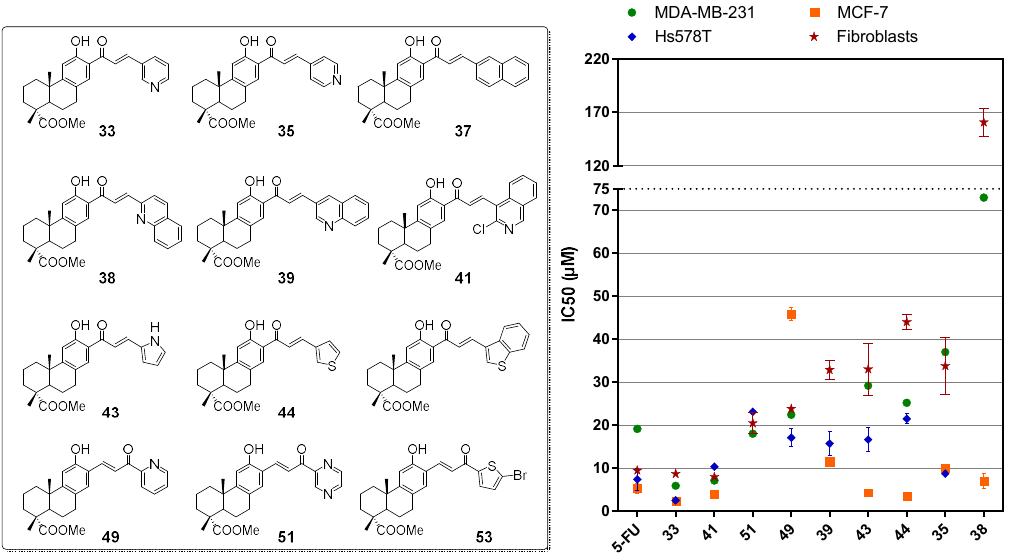
Figure 3. Structures of the most potent compounds and their IC 50 values against all tested cell lines including the positive control (5-FU).